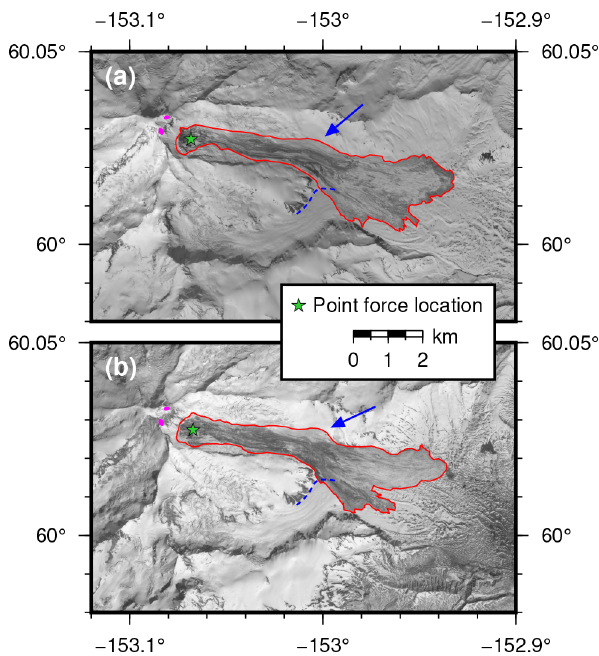
Figure 2. Satellite images of the 2016 and 2019 Red Glacier avalanche deposits acquired on (a) 23 May 2016 and (b) 22 June 2019, both less than 48h post-event. Red outlines delineate approx- imate avalanche extents (source, track, and deposit areas). Green stars mark the location of the inversion point force. Blue arrows in- dicate the location of superelevation-like flow lobes. Blue dashed lines delineate the northern margin of an unnamed tributary glacier which joins Red Glacier from the southwest. Magenta patches show the approximate locations of two fumarole zones located to the east of the summit. Imagery © 2016 and 2019 Planet Labs,